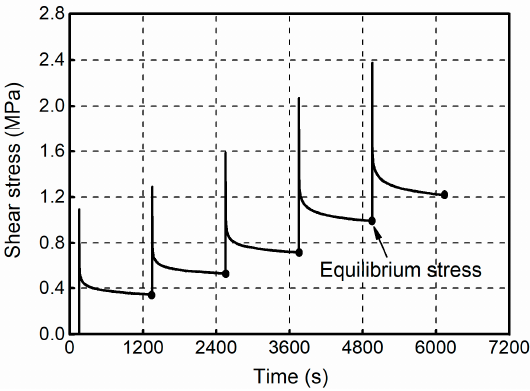
Figure 8. Shear stress obtained from the stress relaxation tests.